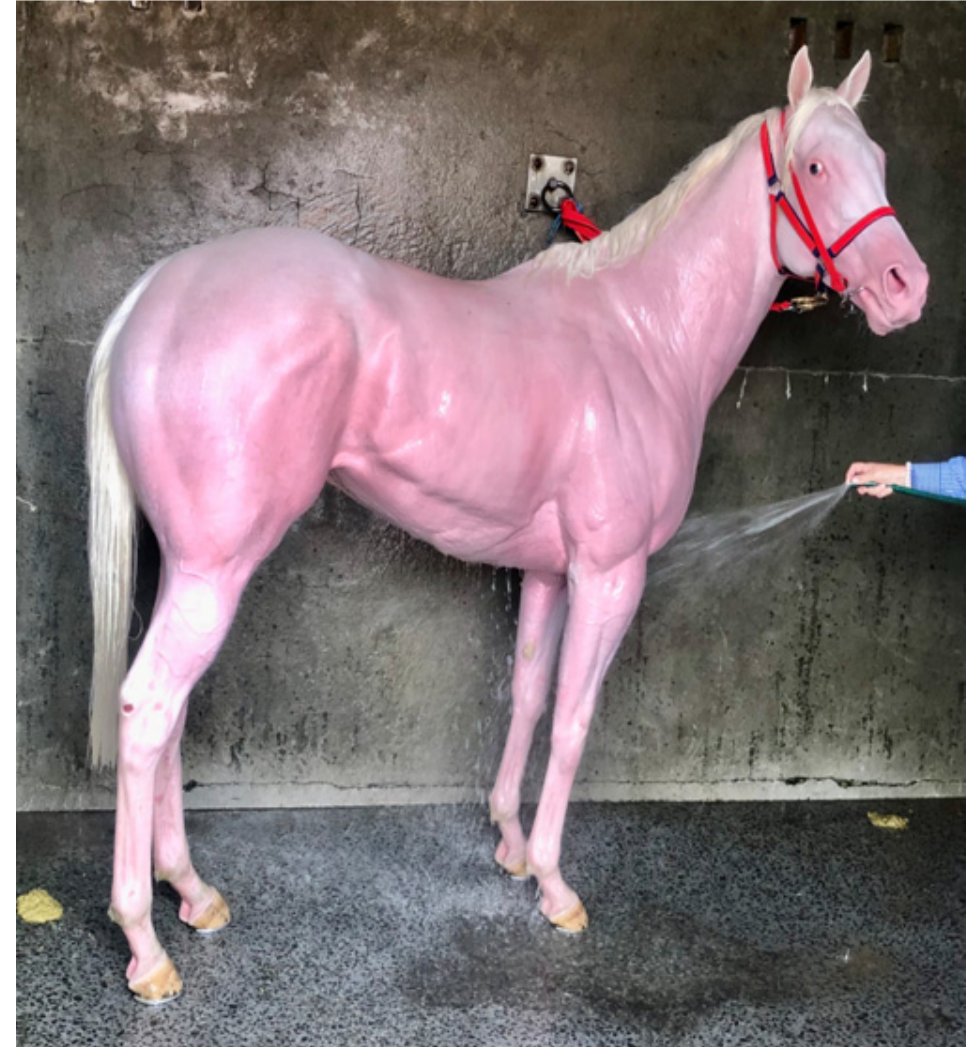
Figure 1. Albino horse in the immediate post-race period on a hot day. The pink colour indicates that almost the entire skin surface has increased blood flow for heat dissipation. Source: J Equine Vet Ed 2021.